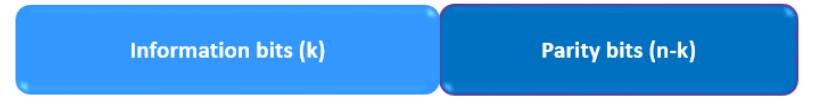
Figure 2. A systematic block code of codeword length n with k information bits and ( n − k ) parity